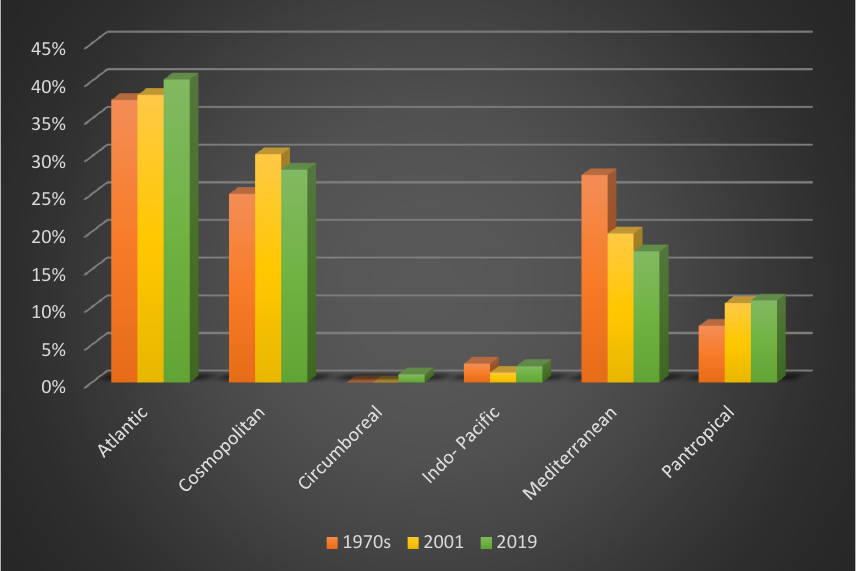
Figure 6. Variations of the percent incidence of Atlantic, Cosmopolitan, Circumboreal, Indo-Pacific, Mediterranean, and Pantropical elements from the 1970s to 2019 in the coralligenous flora of the MPA.